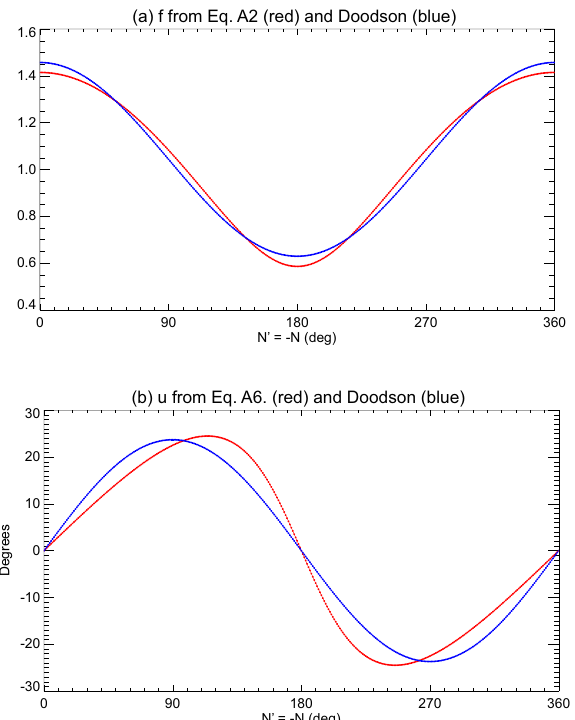
Figure 9. Values of (a) f and (b) u for Mf computed by Eqs. (A2) and (A6) (red) or using the Doodson parameterisations (blue) as a function of N (cid:48) = − N , N being the longitude of the lunar ascending node.